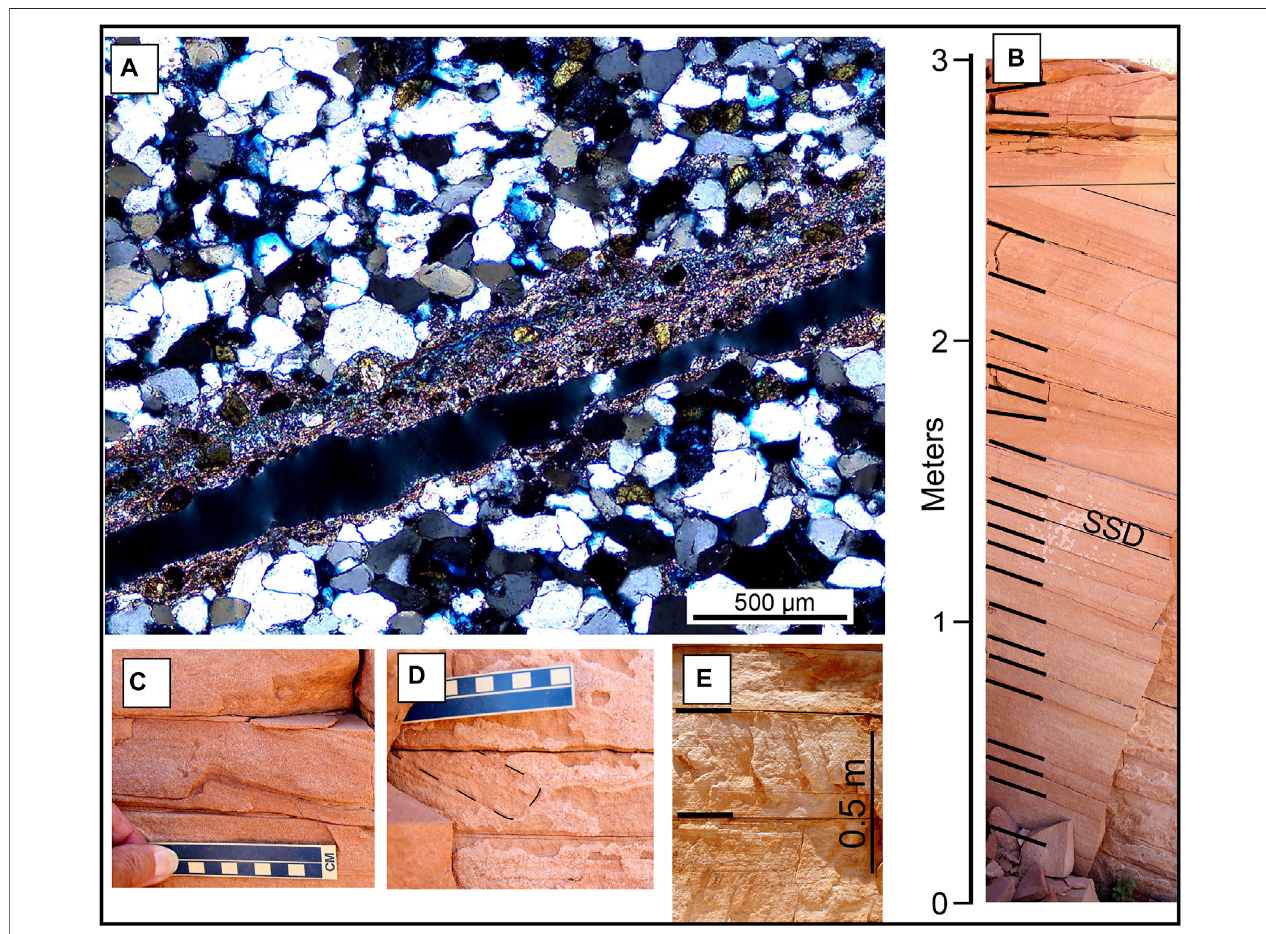
TABLE 1 | Number of each documented type of Coconino Sandstone SSD.